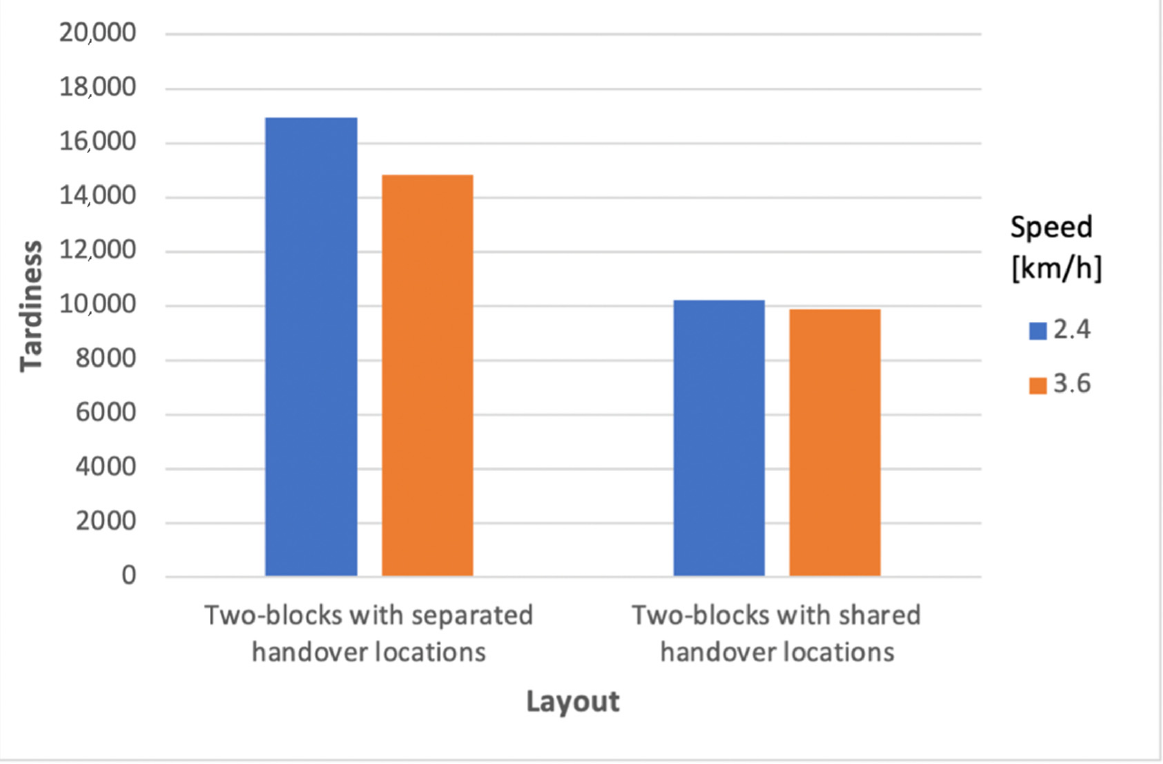
Figure 8. Tardiness values for increasing AMR speeds.